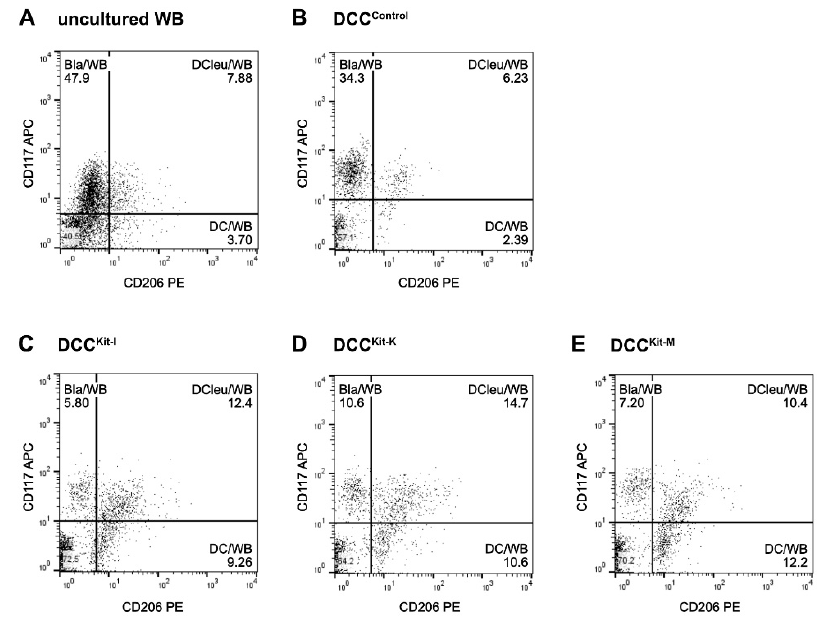
Figure 9. Flow cytometric analyses of DC leu . Examplary plots show DC leu , characterised by the coexpression of the blast marker CD117 and the DC marker CD206, in uncultured WB ( A ) and after kit treatment with Kit-I (DCC Kit-I ) ( C ), Kit-K (DCC Kit-K ) ( D ), Kit-M (DCC Kit-M ) ( E ) as well as the Control (DCC Control ) ( B ).